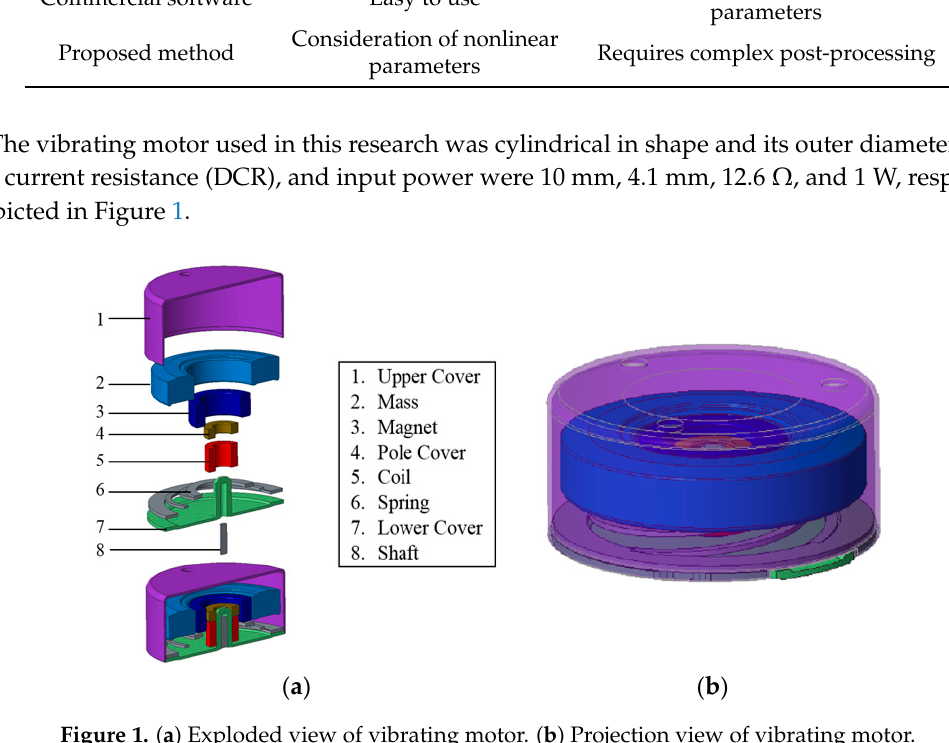
Figure 1. ( a ) Exploded view of vibrating motor. ( b ) Projection view of vibrating motor.